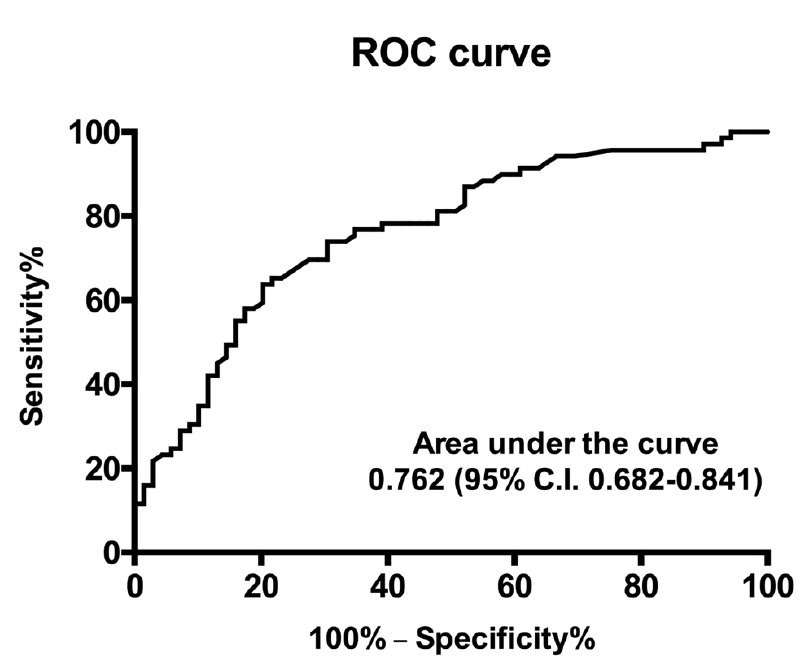
Figure 3. Receiver operating characteristic curve depicting the clinical sensitivity and specificity of plasma Lp(a) values to predict an augmentation index above the median of the distribution. C.I., confidence